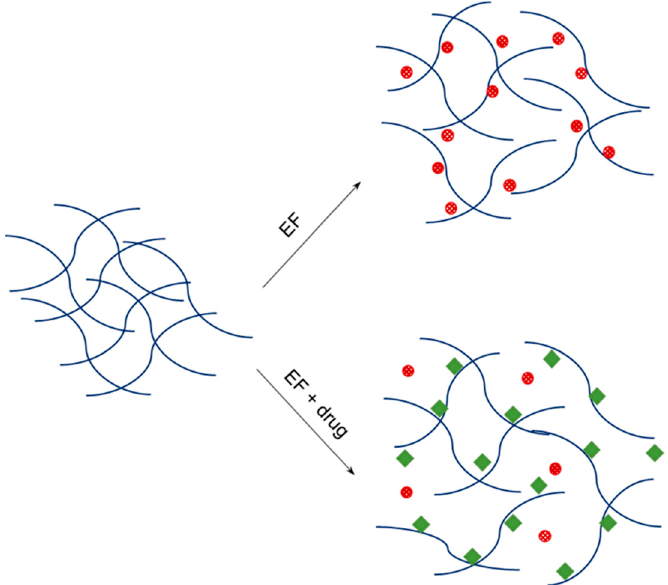
Figure 9. Interactions of ethyl formate (EF) and progesterone with PLGA polymer chains. Progesterone displaces ethyl formate from PLGA polymer chains or acts as a plasticizer to help ethyl formate escape relatively easily.